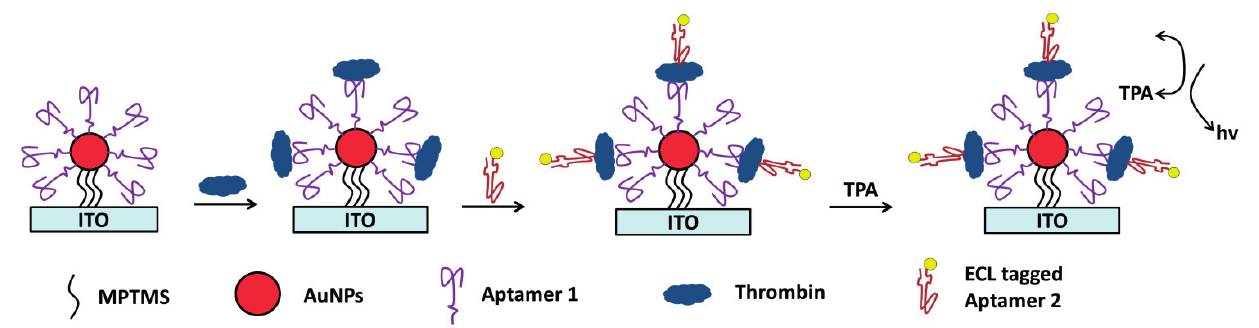
Figure 17. ECL aptasensor for α -thrombin detection using Ru(bpy) 32+ as ECL luminophore. MPTMS, (3-mercaptopropyl)trimethoxysilane; ITO, indium tin oxide; TPA, tri- n -propylamine; AuNPs, gold nanoparticles. Reprinted with permission from ref. [81] copyright (2008) Elsevier.